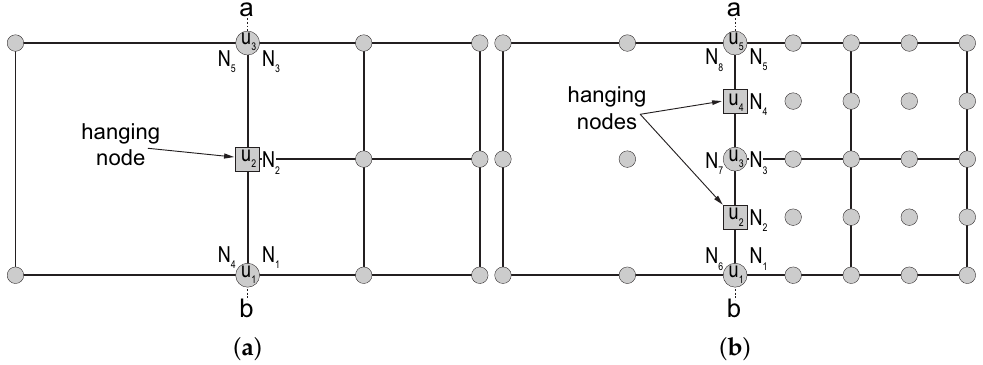
Figure 9. Typical segments of a multilevel grid for ( a ) bilinear ( Q 1 ) and ( b ) biquadratic ( Q 2 ) ba- sis